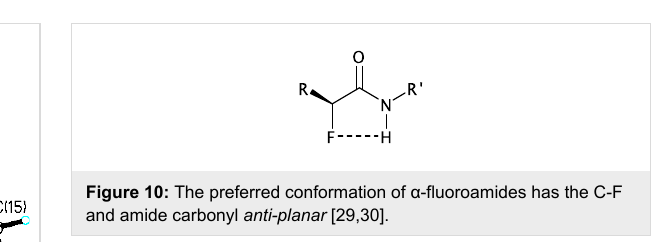
Figure 10: The preferred conformation of α-fluoroamides has the C-F and amide carbonyl anti-planar [29,30].